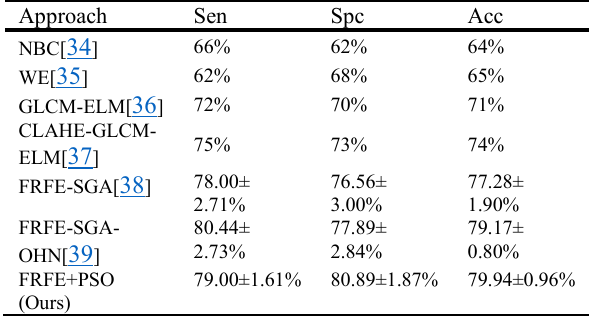
Table 3. Comparison of our method with state-of- the-art